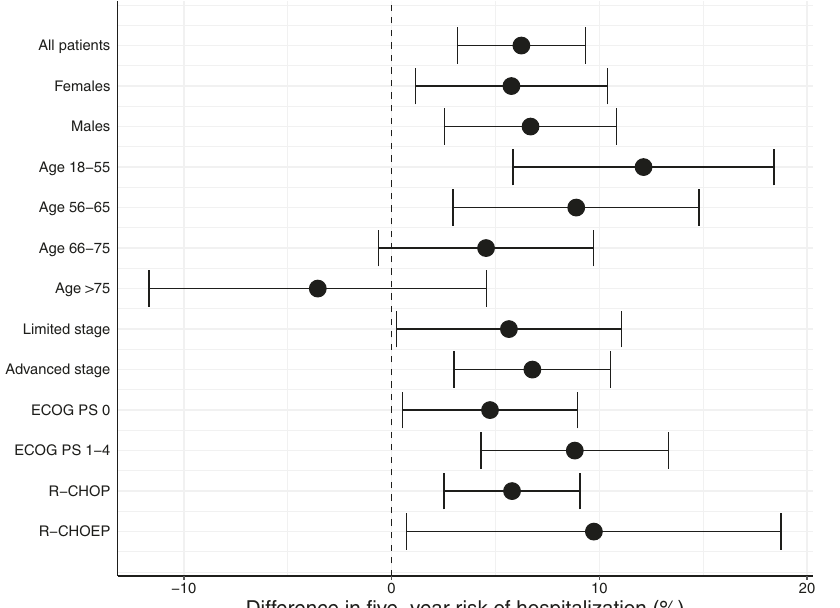
Fig. 1 Differences in post-remission 5-year risk of hospitalization between DLBCL survivors and matched comparators from the Danish general population. The differences are reported overall and within clinical subgroups. Elevated risks of hospitalization among DLBCL survivors correspond to a positive risk difference and error bars indicate 95% con fi dence intervals. ECOG PS Eastern Cooperative Oncology Group performance status.